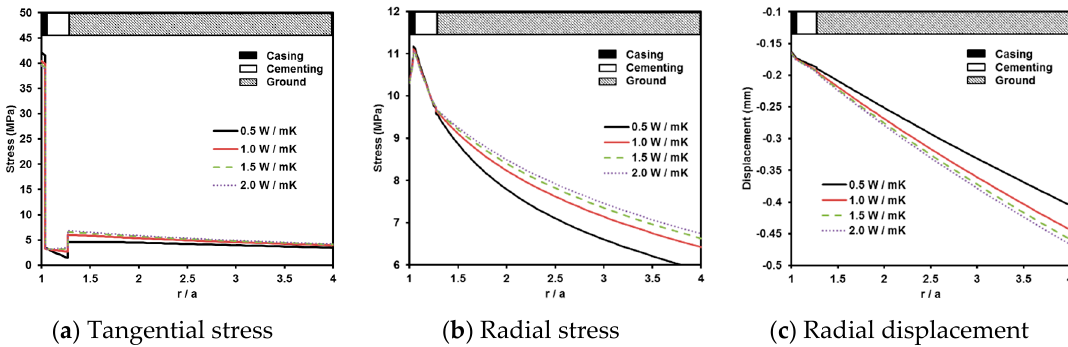
Figure 8. Stress and displacement at 2500 m with variation of thermal conductivity of the cementing component.